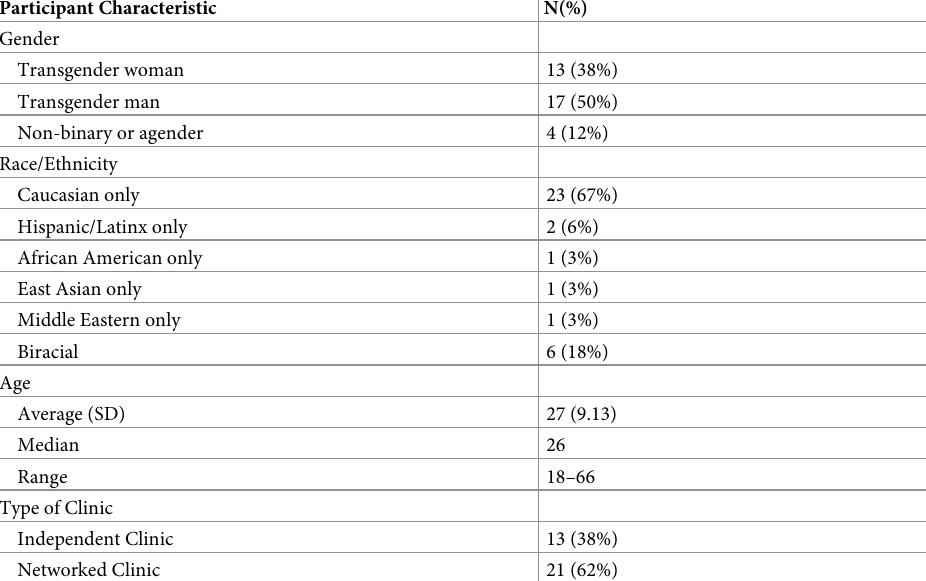
Table 1. Participant demographics (n =